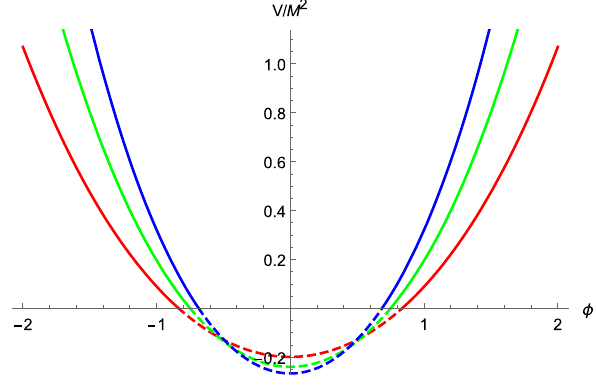
Fig. 6 Behavior of potential V (φ) associated with the solution III for different values of γ 0 . The red, green, and blue curves correspond to γ = 1, 1 . 5, and 2, 0